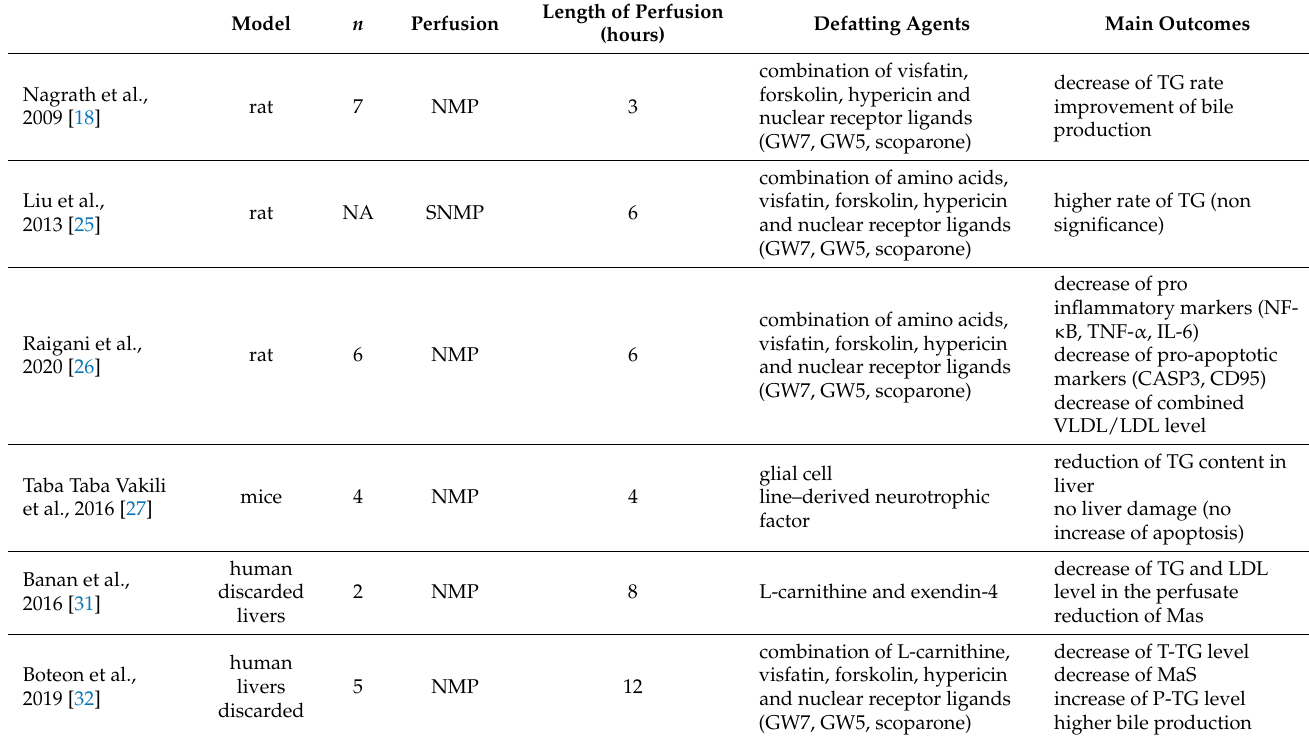
Table 2. Drugs used in experimental models for ex-vivo defatting of steatotic